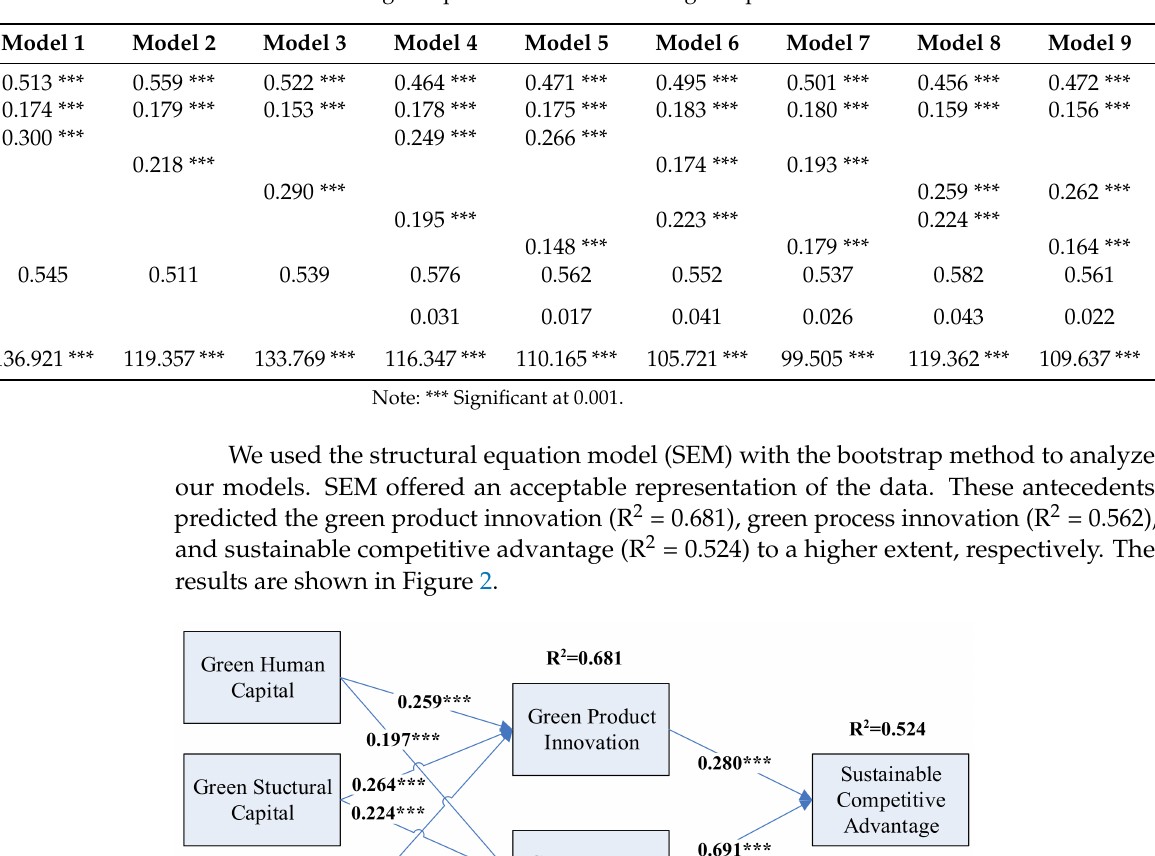
Table 4. The mediation effect of green product innovation and green process innovation.